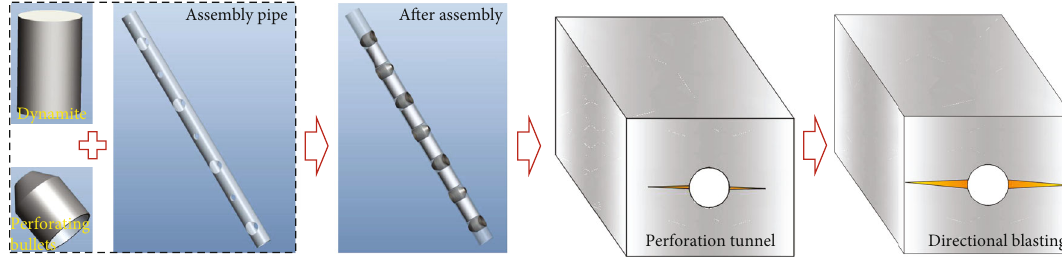
Figure 11: Process of the